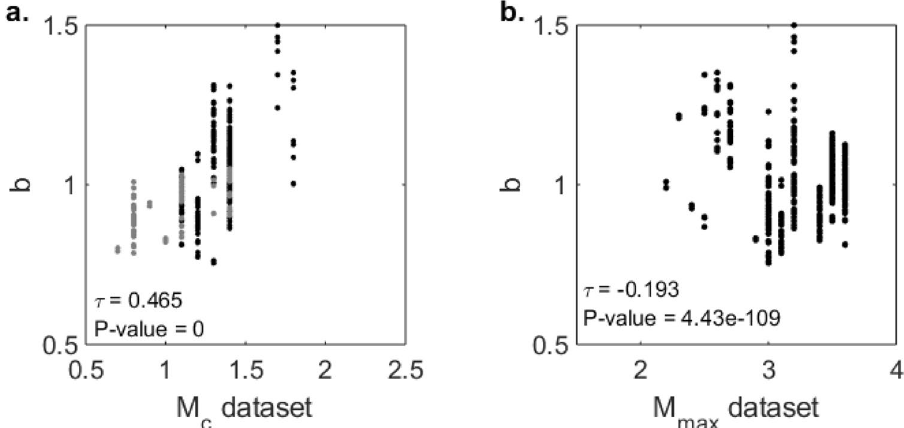
Figure 4. Plots of the b -values derived in the solutions used to compute the temporal median b -values as a function of magnitude of completeness (a ) and largest observed magnitude in the dataset analysed ( b ). ( a ) b -value as a function of magnitude of completeness for the temporal analysis. The grey dots correspond to the solutions for the temporal nodes after 1-1-2014. ( b ) b -value as a function of the largest observed magnitude in the dataset for the temporal analysis. In each plot we report the correlation coefficient τ and the P-value obtained by the Kendall-Tau test for the null hypothesis of no